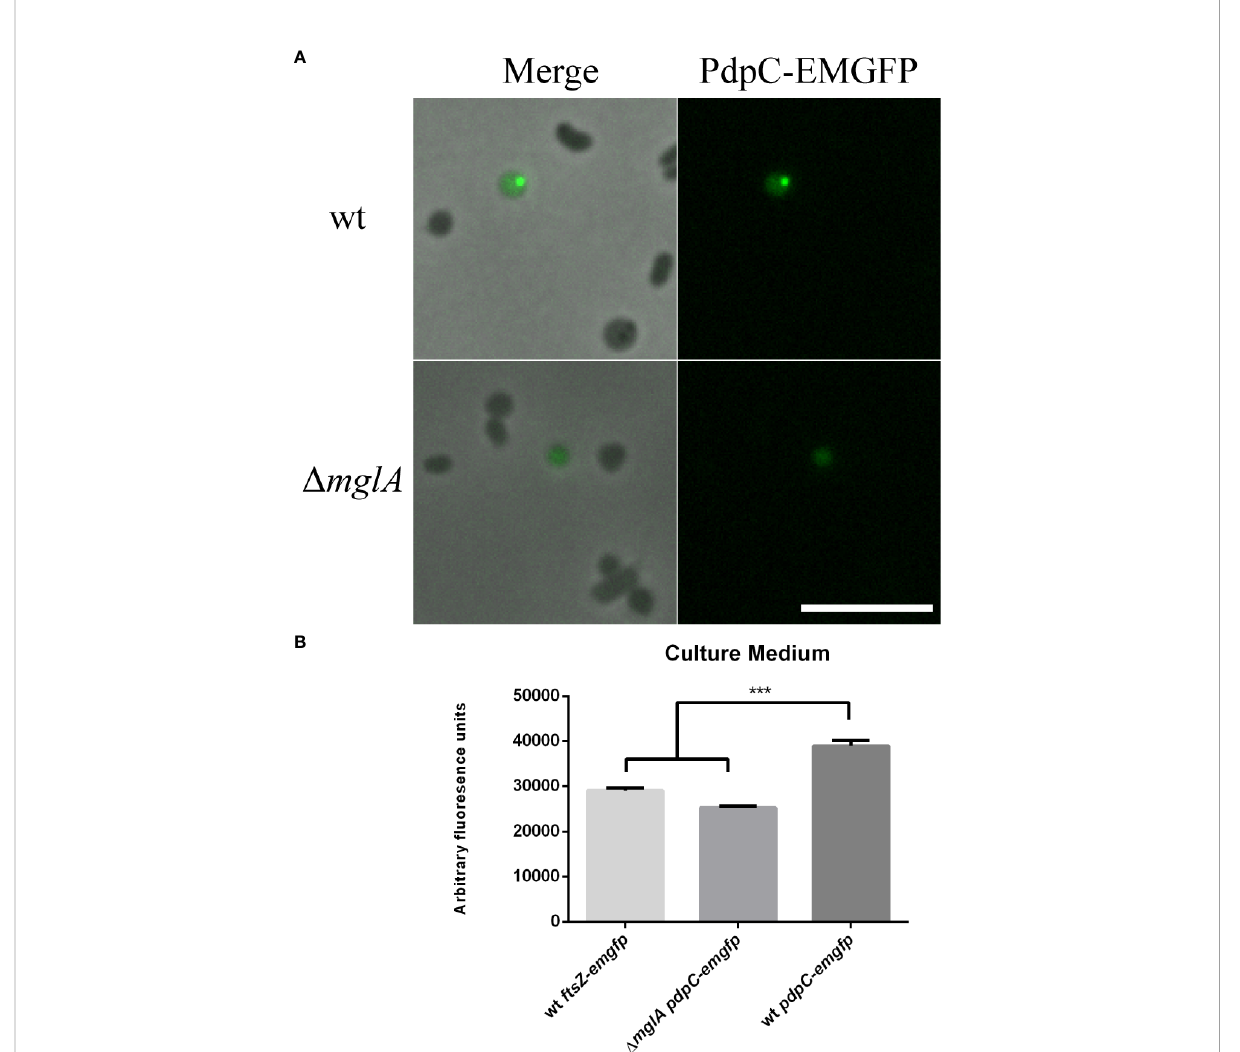
FIGURE 4 PdpC-EMGFP localizes as foci in F. tularensis and localization and secretion is dependent on mglA . F. tularensis LVS strains containing a copy of pdpC-emgfp , in trans , under the control of the FGRp promoter were grown for 24 hours in CDM at 37°C. (A) Punctate foci could be seen in a small subset of wt cells (top) whereas only diffuse fl uorescence was seen for an mglA mutant (bottom). Scale bar equals 5 µm. (B) Filter sterilized supernatant from the wt containing pdpC-emgfp showed signi fi cantly higher fl uorescence than supernatants from either an mglA- null mutant or the wt strain expressing ftsZ - emgfp , a cytosolic protein which is not secreted (*** p < 0.001 determined by ordinary 1-way ANOVA with Tukey ’ s multiple comparisons test). The averages of six independent experiments are shown ± the standard